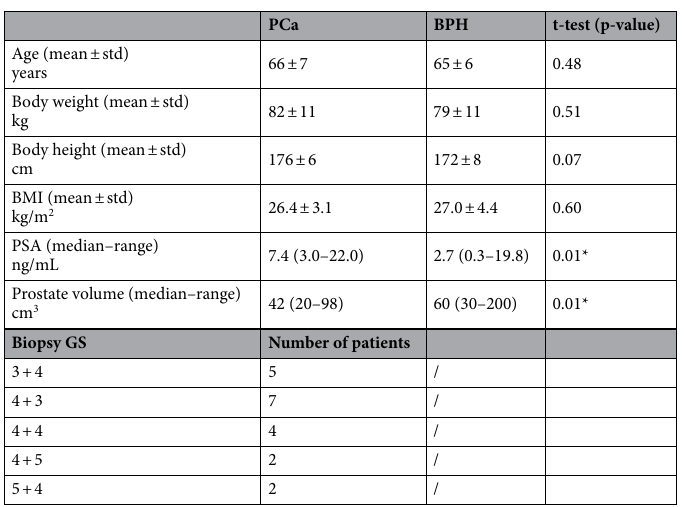
Table 3. Characteristics and clinical data of the enrolled patients. Symbol (*) indicates the features showing a significant p-value (lower than 0.05) for the performed Student’s